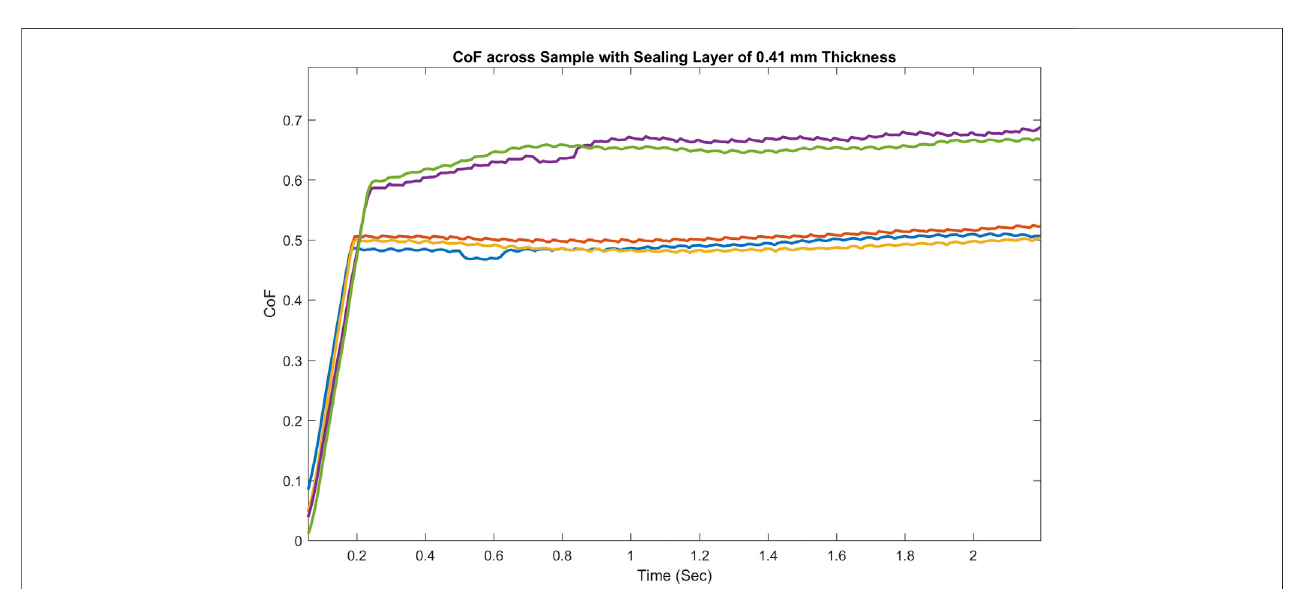
FIGURE 7 | Example CoF vs. Time for the non-activated and activated composite pad samples.